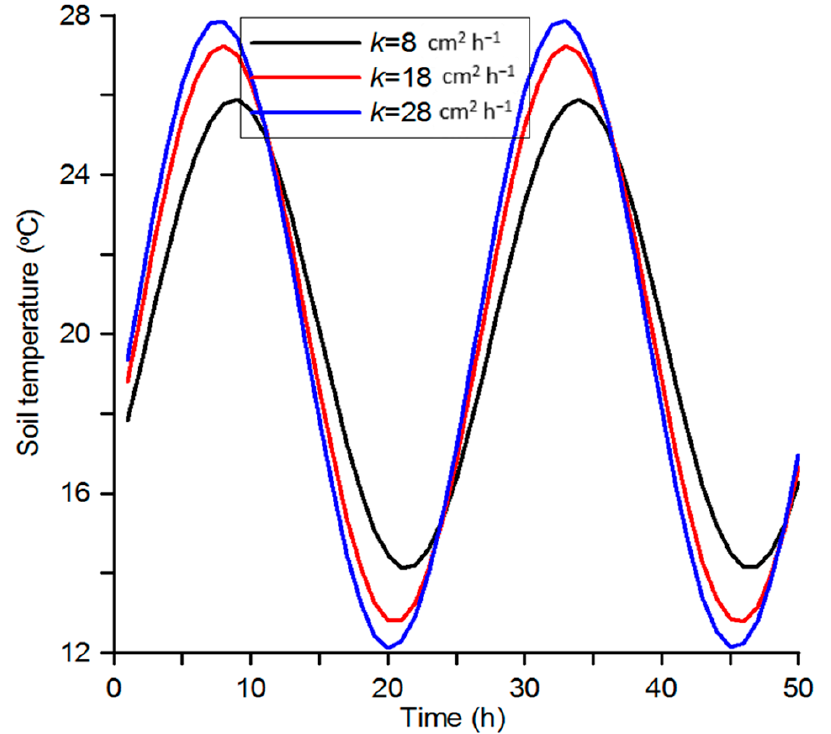
Figure 7. Dynamics of soil temperature variation at a depth of 5 cm at different values of thermal diffusivity of soil.